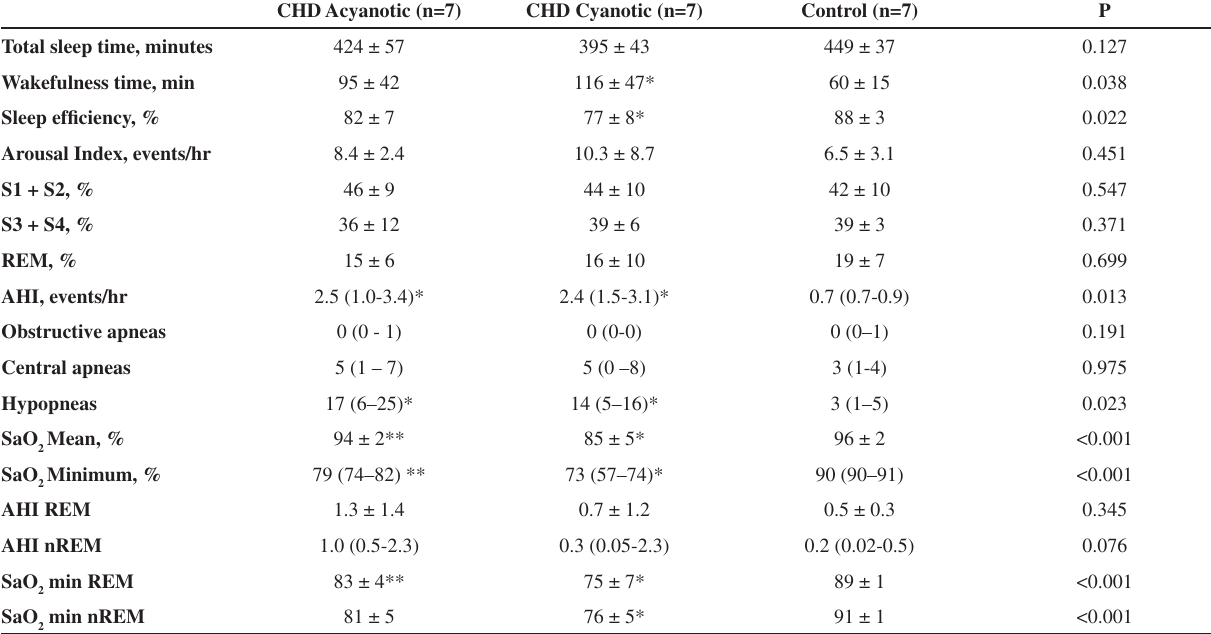
*Different from control group, **Different between acyanotic and cyanotic groups. SaO S1, S2, S3 and S4 correspond to Stage 1, Stage 2, Stage 3 and Stage 4 of sleep, respectively. The p-value corresponds to the comparison of the three groups. Significant differences between groups (p <0.05) are indicated with